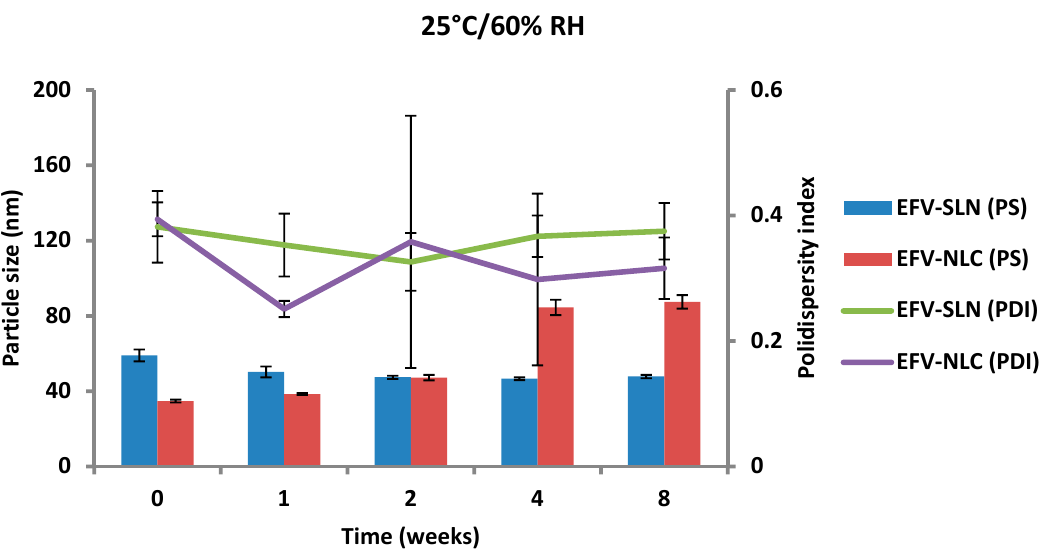
Figure 13. Particle size and size distribution of SLN and NLC following storage at 25 °C/60% RH .